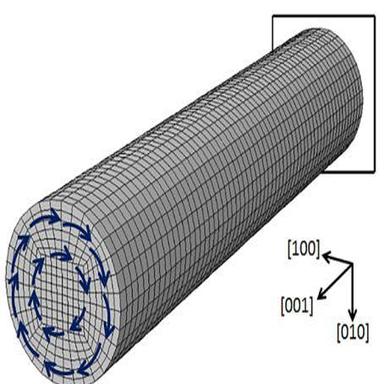
Finite element mesh and boundary conditions of the simulated shaft with radius 2 μm and length 20 μm.